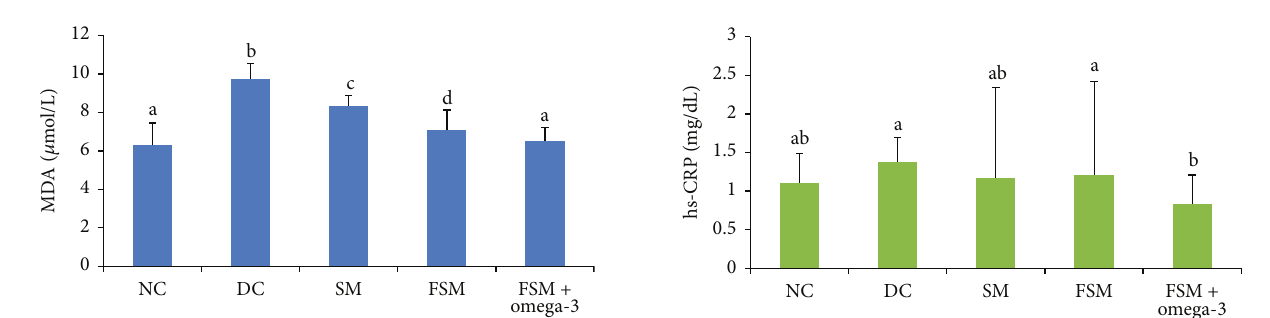
Figure 3: hs-CRP concentrations within the five groups. NC = normal control, DC = diabetic control, SM = diabetic rats that received soymilk, FSM = diabetic rats that received fermented soymilk, and FSM + omega-3 = diabetic rats that received fermented soymilk fortified with omega-3. Each value is expressed as mean ± SD. Values with different letters are significantly different at 𝑃 < 0.05 as analyzed by Duncan’s multiple range